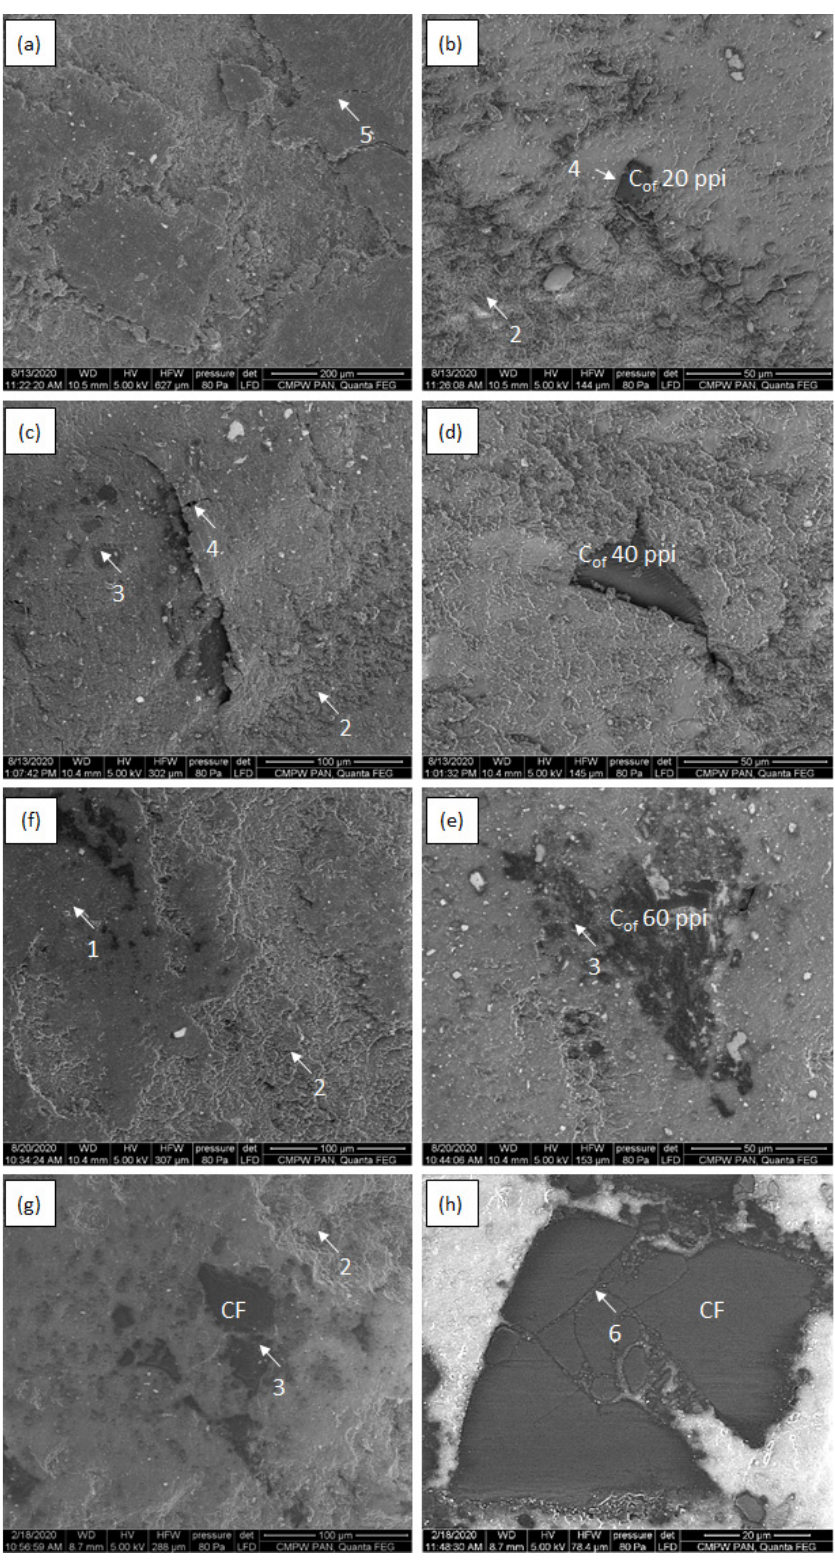
Figure 9. SEM micrographs of epoxy—C of 20 ppi ( a , b ), epoxy—C of 40 ppi ( c , d ),epoxy—C of 20 ppi ( e , f ) and epoxy–CF ( g , h ) after cooperation with cast iron counter sample under 2.1 MPa load; 1—abrasive wear of carbon foam, 2—abrasive and adhesive wear and shear and transfer of matrix, 3—solid tribofilm, 4—cracks at interface, 5—matrix delamination, 6—cracks in glassy carbon structure.